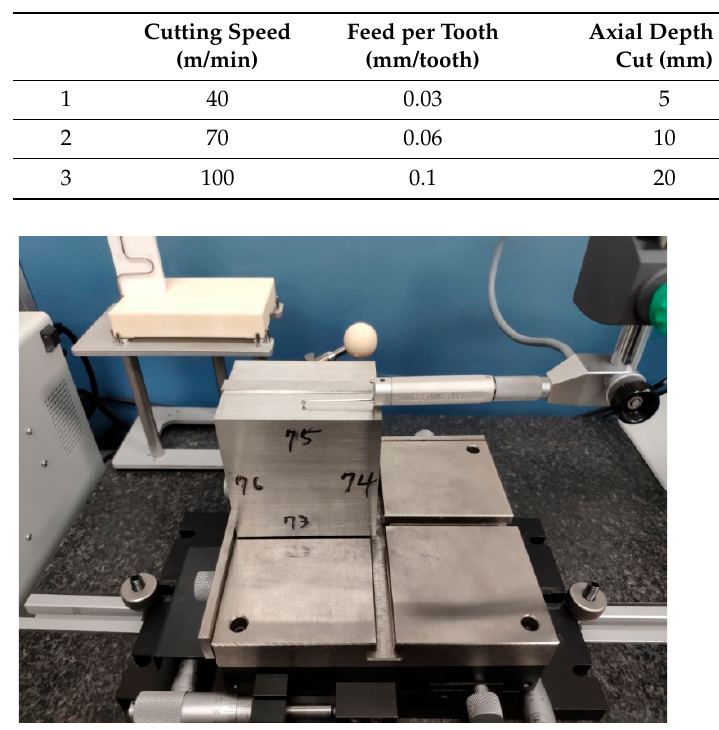
Figure 3. Roughness measurement.